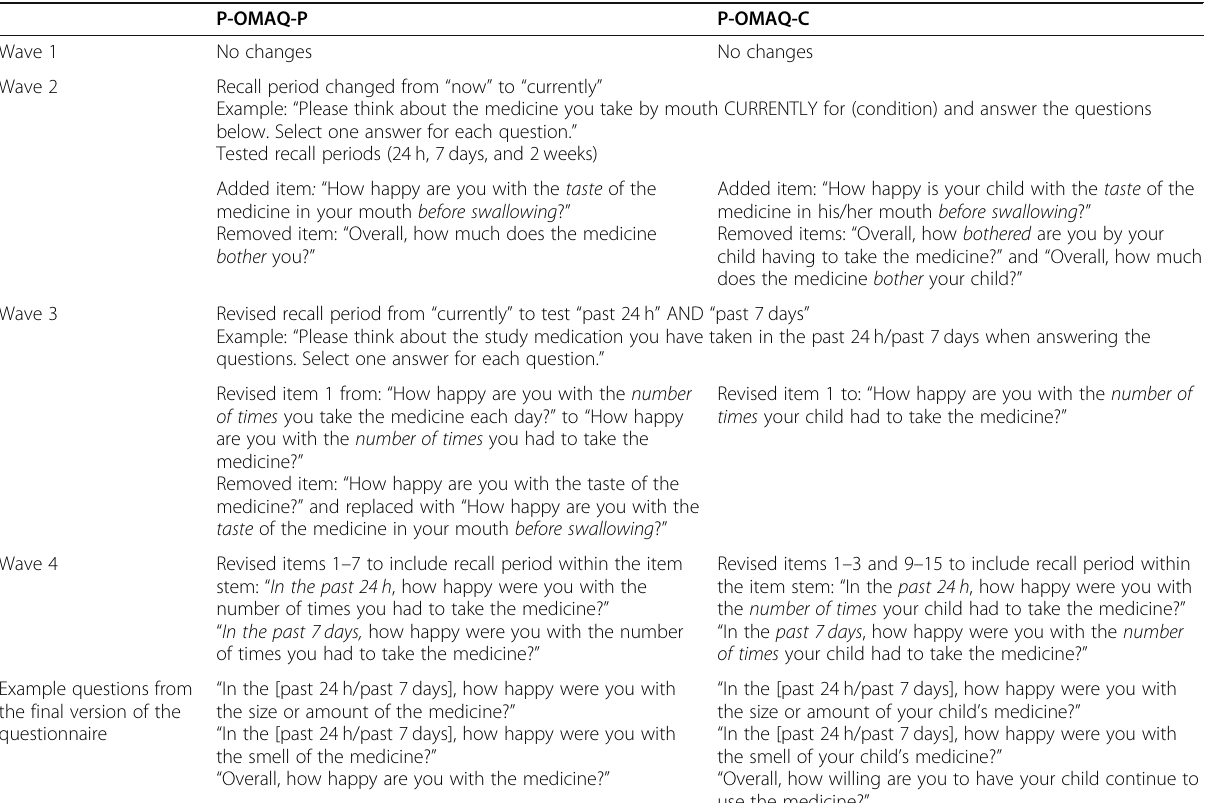
Table 6 Revisions to the P-OMAQ-P and P-OMAQ-C questionnaires following the concept elicitation and cognitive debriefing